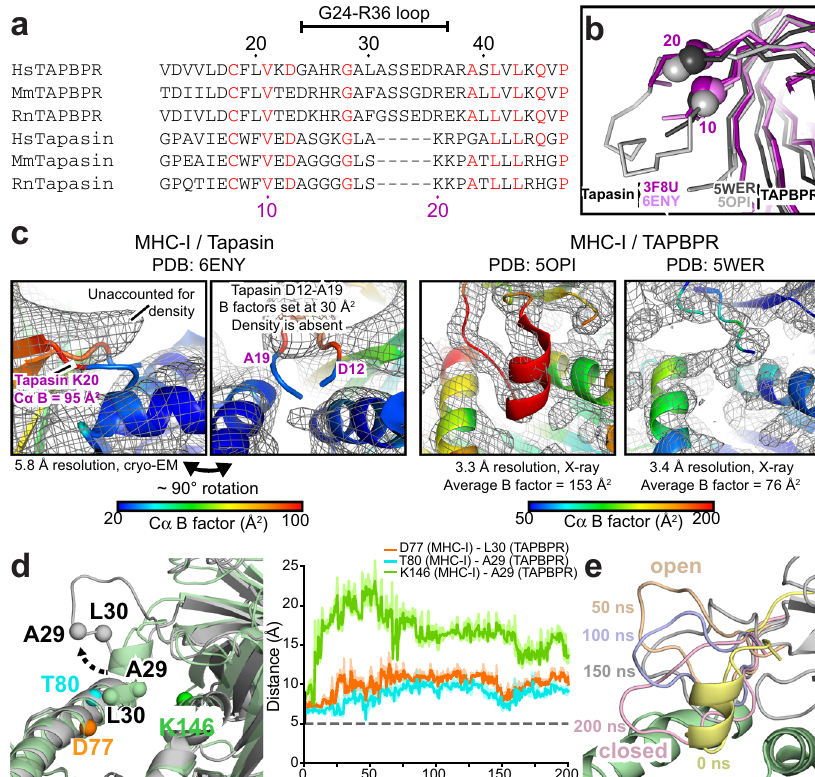
Fig. 1 Conformational plasticity of the TAPBPR G24-R36 loop. a Sequence alignment between TAPBPR and tapasin from Homo sapiens (Hs, human), Mus musculus (Mm, mouse), and Rattus norvegicus (Rn, rat) highlighting differences in the TAPBPR G24-R36 loop region. Black and purple numbering reference TAPBPR and tapasin, respectively. Red residues are conserved. b Overlay of X-ray structures of tapasin (PDB IDs 3F8U and 6ENY) and TAPBPR (PDB IDs 5WER and 5OPI). c (Left) Cryo-EM density map (gray mesh, 5.0 σ ) plotted on the cartoon of MHC-I in complex with tapasin (PDB ID 6ENY). (Right) 2F o - F c electron density maps (gray mesh, 1.0 σ ) plotted on the cartoon of MHC-I in complex with TAPBPR (PDB ID 5OPI and 5WER). The cartoons are colored by C α B factors. d (Left) Before (green) and during (gray) snapshots of peptide-de fi cient HLA-A*02:01/h β 2 m/TAPBPR complex from all-atom MD simulations. The C α atoms used for distance measurements are shown as spheres. (Right) Intermolecular C α -C α distances measured between HLA- A*02:01 groove (D77, T80, K146) and TAPBPR G24-R36 loop (A29, L30) residues over the course of the simulation. The dotted line represents C α -C α distances at the start of the simulation. e The range of conformations of the TAPBPR G24-R36 loop captured at different times during the MD simulation. The open (wheat, 50 ns) and closed (pink, 200 ns) states of the TAPBPR G24-R36 loop are oriented away from and covering the HLA-A*02:01 groove, respectively. The MHC-I groove (green) and TAPBPR N domain (gray) are shown as a static snapshot from the 0 ns MD time point for